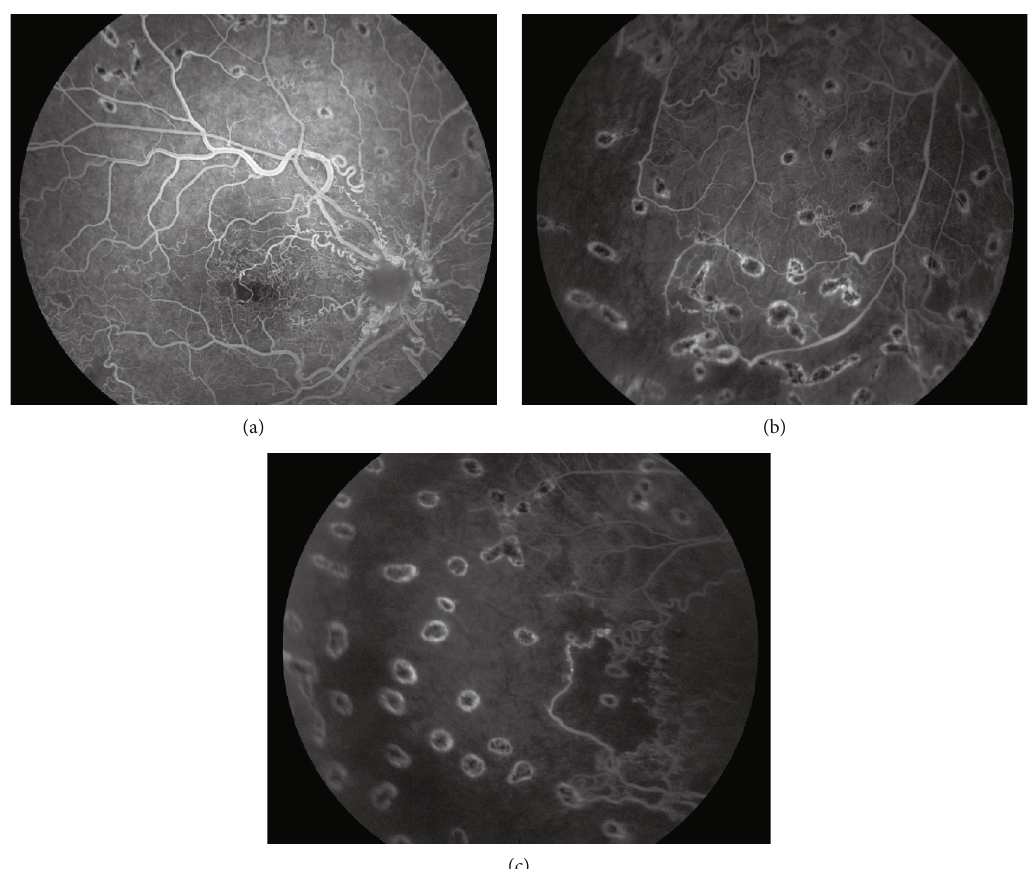
Figure 3: Fluorescein angiography of the a ff ected right eye of the patient. (a) Abnormal arteriovenous communications with microangiopathy in the macula and an enlarged foveal avascular zone. (b, c) Di ff use capillary drop out in retinal periphery. No peripheral neovascularization is observed; however, pictures were taken 2 weeks after peroperative intravitreal anti-VEGF